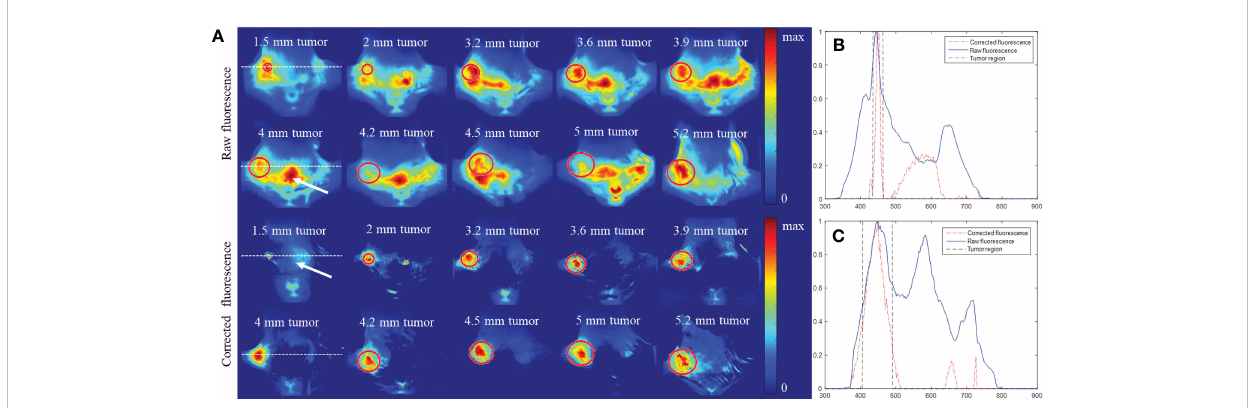
FIGURE 7 Comparison of fl uorescence distribution before and after background subtraction for 10 mice bearing 4T1 breast tumors of different sizes. All the fl uorescence images were obtained 1 day after intravenous injection of PLGA-anti-EGFR nanoparticles. (A) Raw and background-corrected fl uorescence images, which were normalized by their own maximum. The circle marks the tumor differentiated from contrast CT. (B, C) Pro fi les across the 1.5 mm and 4 mm tumor, respectively (along the dotted lines in the 1st column of (A) ). All the pro fi les were normalized to their own